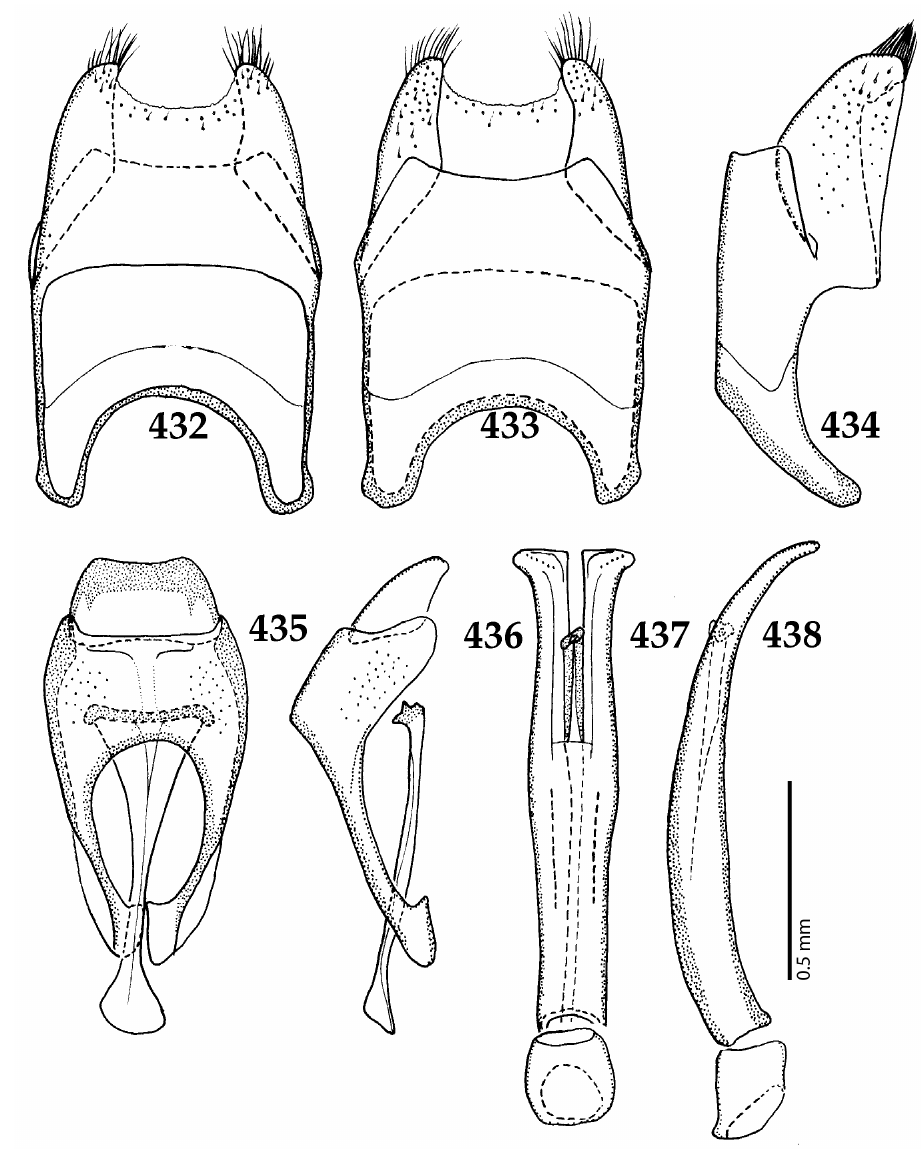
Figures 432–438. 432 Saprinus ( Saprinus ) detritus (Fabricius, 1775) male terminalia: 8 th sternite + 8 th tergite, ventral view 433 ditto, dorsal view 434 ditto, lateral view 435 male terminalia: 9 th + 10 th tergites, dorsal view; spiculum gastrale, ventral view 436 male terminalia: 9 th + 10 th tergites; spiculum gastrale, lateral view 437 male terminalia: aedeagus, dorsal view 438 ditto, lateral view.